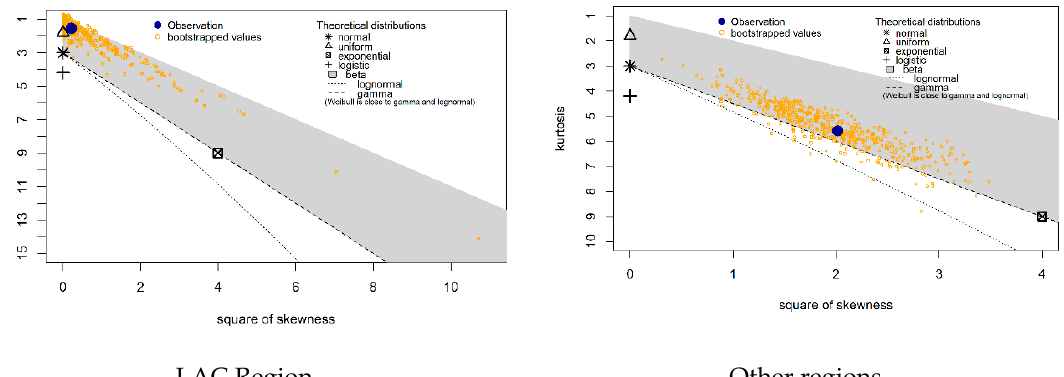
Figure 7. Cullen and Frey graph of the citations per document of journals from LAC and other regions.